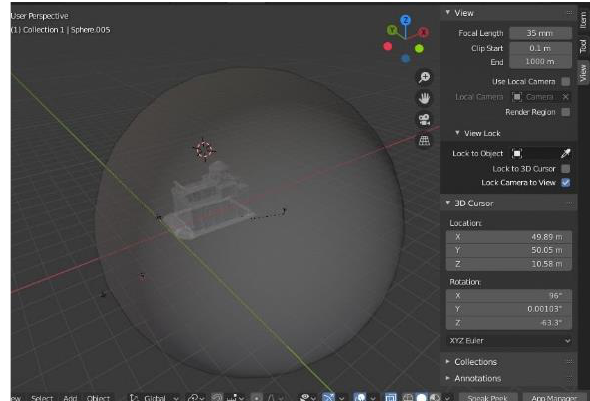
Figure 11. The creation of the environmental spheres in Blender that involved the 3D model of the